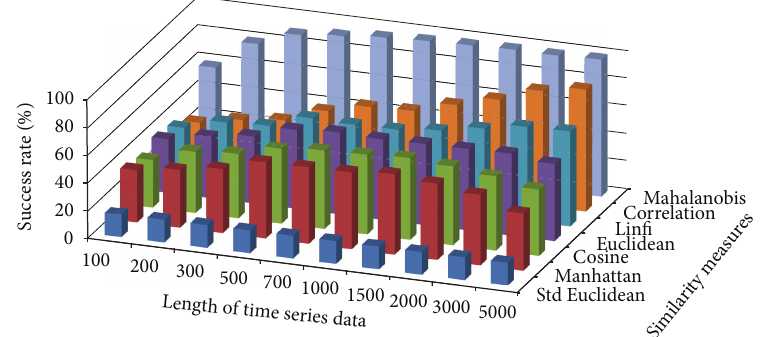
Figure 5: Average success rate of pattern recognition with different similarity measures and the length of time series in second scenario.